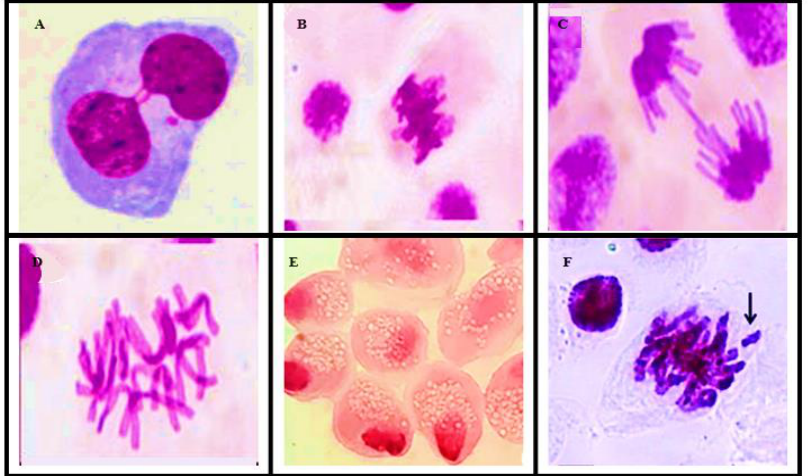
Figure 5. Optical microscope photomicrographs of chromosomal aberrations: ( A ) binucleation, ( B ) metaphase with adherence, ( C ) anaphase with bridge, ( D ) C-metaphase, ( E ) necrosis, and ( F ) chromosomal loss.